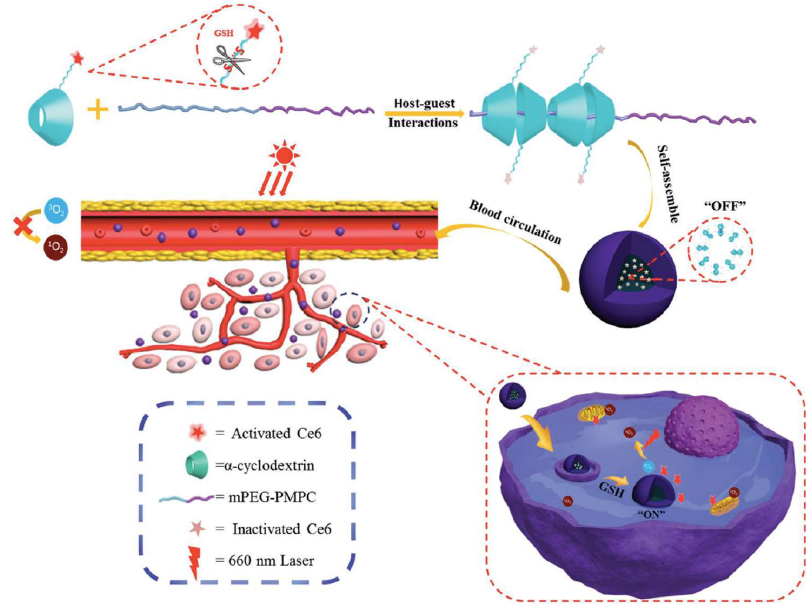
Figure 7. Schematic illustration of glutathione (GSH)-activable PS-conjugated pseudopolyrotaxane nanocarriers for photodynamic theranostics. Reproduced from Reference [42] with permission from Small , 2016.